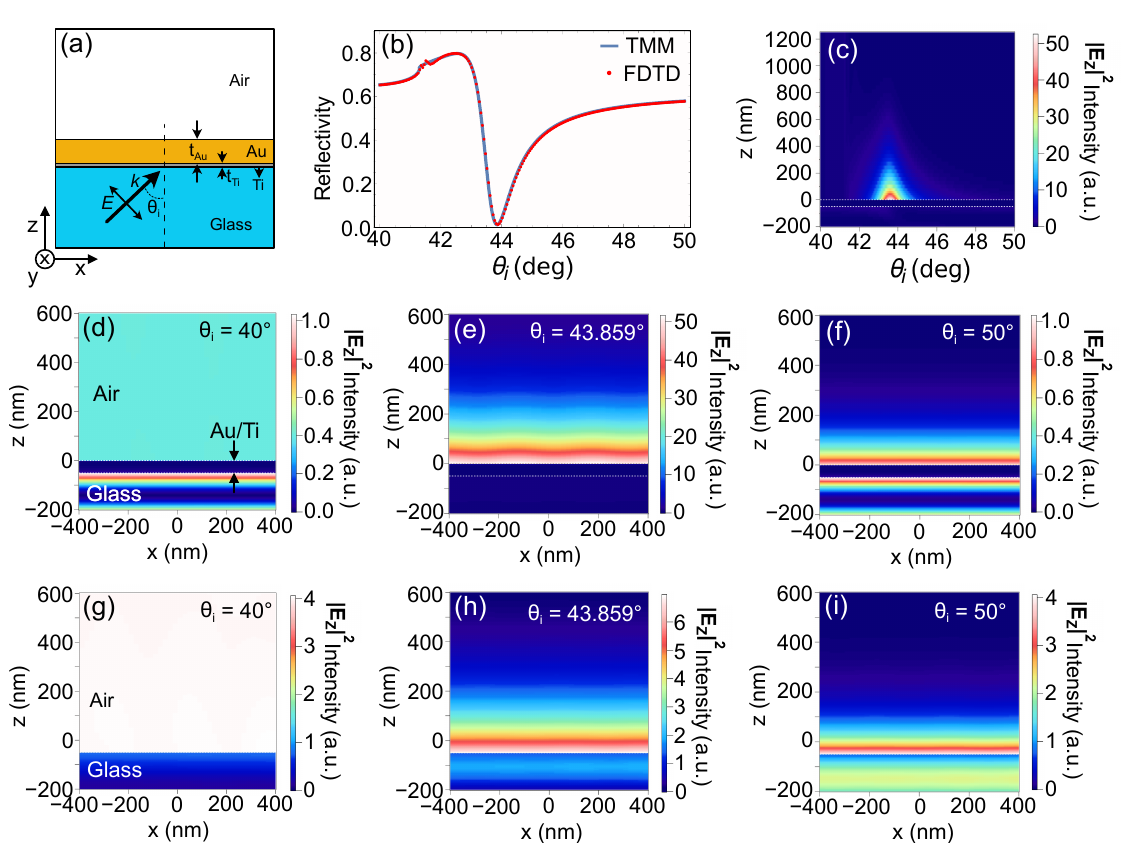
Figure 2. ( a ) Model used for FDTD simulations consisting of Au ( t Au = 47.5 nm), Ti ( t Ti = 2.5 nm) and glass layers illuminated by a linear p -polarized electric field at an incident angle θ i . ( b ) Comparison of reflectivity calculated using FDTD (solid red circles) and analytically using TMM (solid blue line). ( c ) Rapidly decaying electric field at SPR in the z direction at various angles of incidence. Electric field distribution at the ( d – f ) BK7/Ti/Au/air and ( g – i ) BK7/air interface for: ( d , g ) incident angle smaller than the SPR angle ( θ i = 40 ◦ ); ( e , h ) incident angle equal to the SPR angle ( θ i = 43.859 ◦ ), and ( f , i ) incident angle larger than the SPR angle ( θ i = 50 ◦